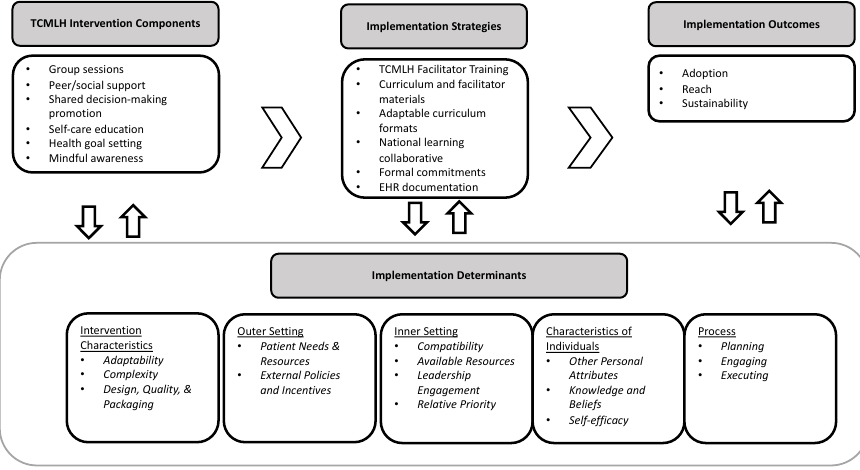
Figure 1. TCMLH Intervention and Implementation Logic Model.